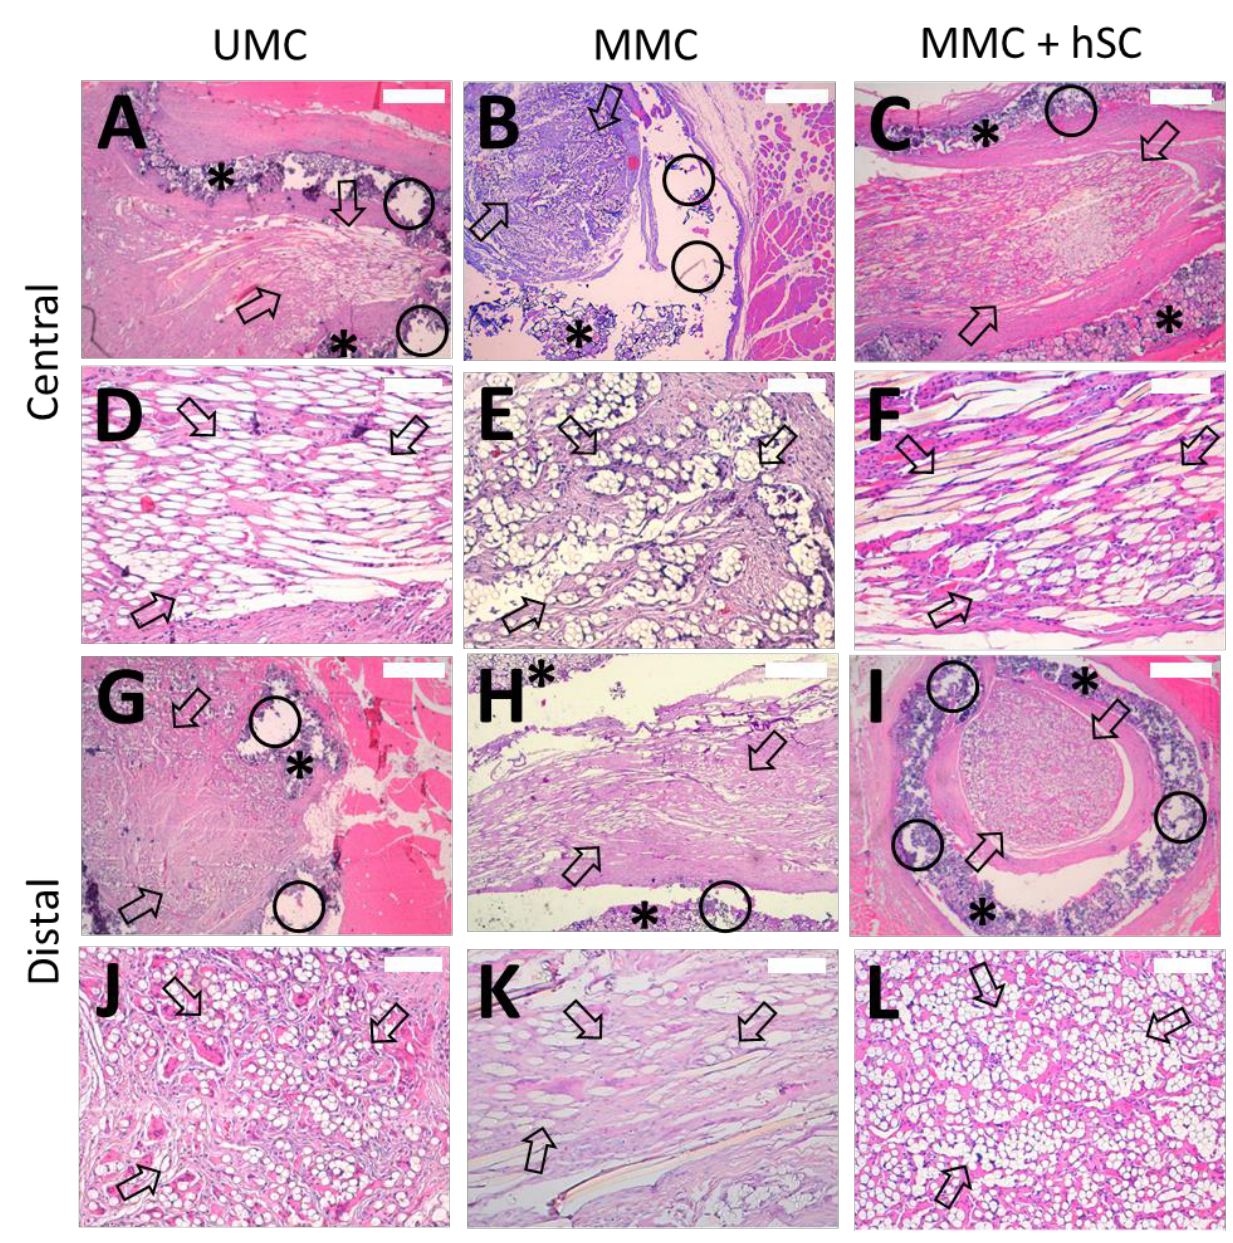
the presence of a high amount of myelinated nerve fibers in all the experimental groups, with a similar content of myelinated nerve fibers at the central and distal portions.